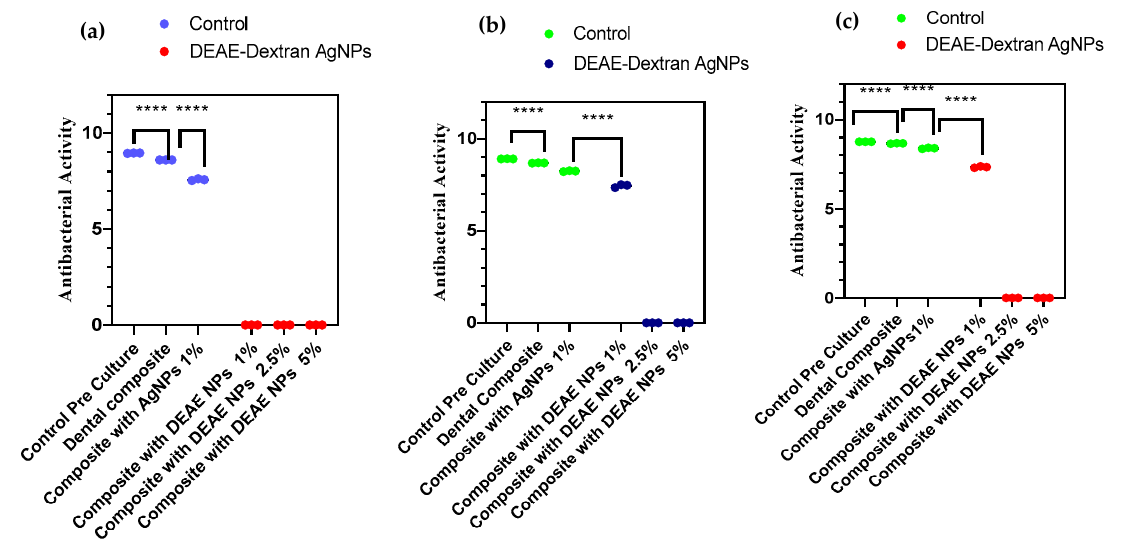
Figure 6. CFU/mL of: ( a ) S. mutans , ( b ) E. faecalis , and ( c ) microcosm models: antibacterial effect of modified composite resin disks (**** = p < 0.0001).